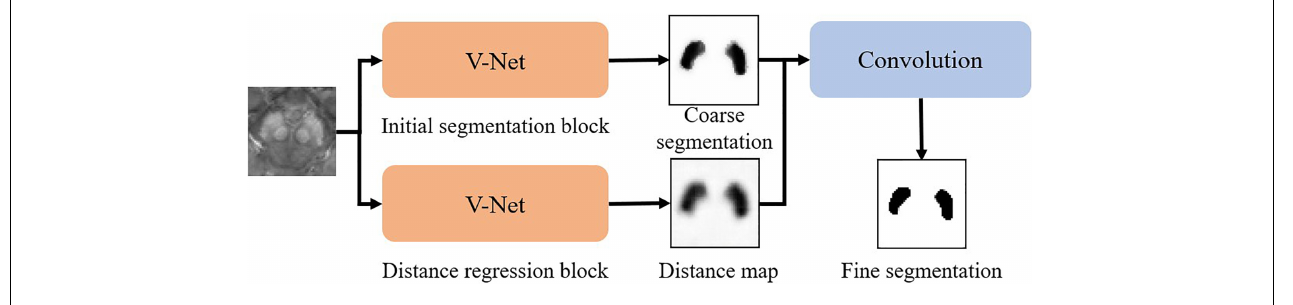
FIGURE 2 | The architecture of SN 2 used for substantia nigra labeling.